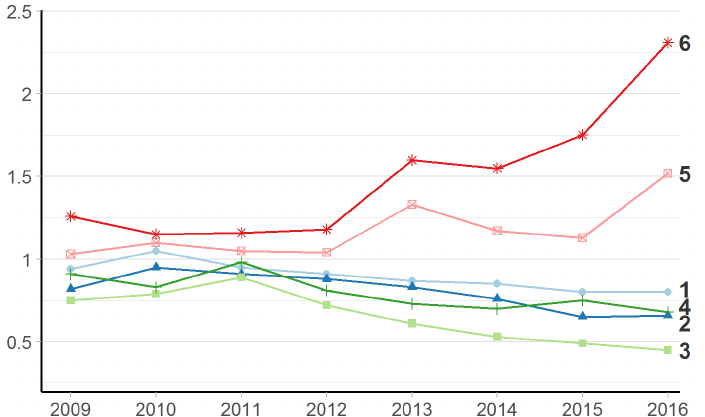
Figure 8. The rate of change in individual indicators that characterize the process of adaptation of the Ukrainian economy to changes in energy prices and to risks of energy markets, relative to 2007: